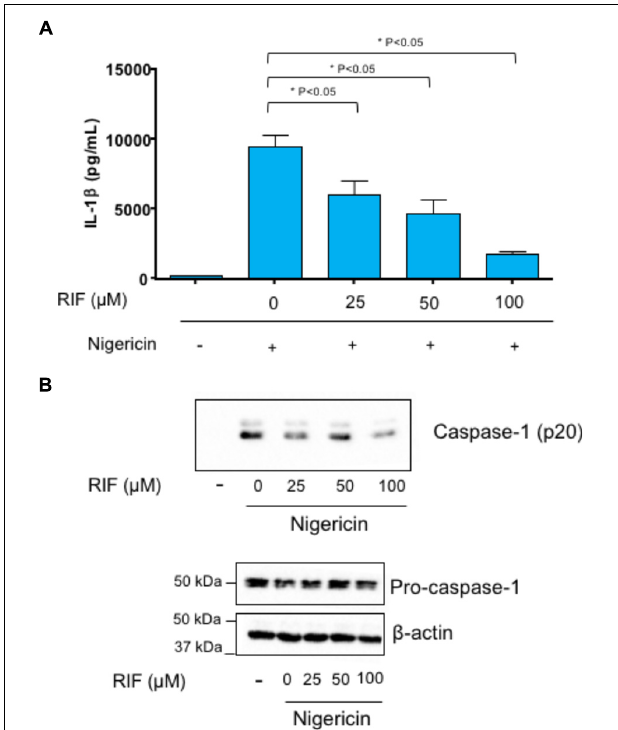
FIGURE 7 | Lipopolysaccharide-primed THP-1 cells treated with rifaximin (RIF, 25, 50, or 100 µ M) before the addition of nigericin (10 µ M). (A) Effect of rifaximin (RIF) on interleukin-1 β (IL-1 β ) release in cell supernatants. (B) Effect of rifaximin (RIF) on caspase-1 p20 expression in cell supernatants as well as on pro-caspase-1 expression in cell lysates. Each column represents the mean ± SEM value obtained from four separate experiments. ∗ p < 0.05, significant difference versus cells treated with nigericin